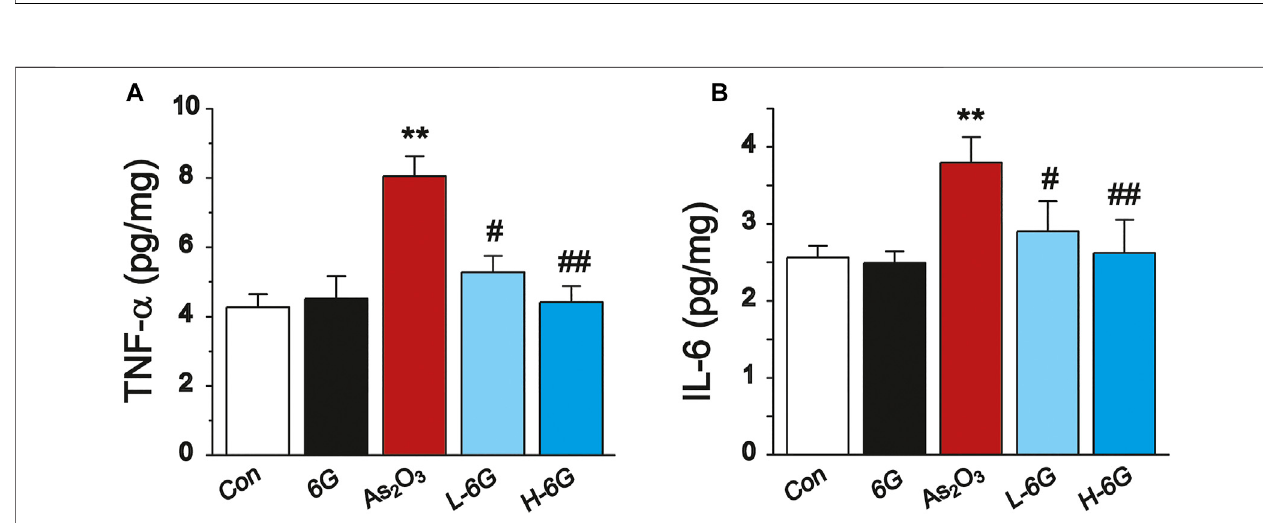
FIGURE 8 | ELISA analysis of in fl ammatory cytokines. The effects of 6G on the levels of TNF- α (A) and IL-6 (B) in myocardial tissues of each group. Data are expressed as mean ± SEM, n = 3. ** p < 0.01 as in comparison to the Con group and # p < 0.05, ## p < 0.05 as in comparison to the As 2 O 3 group.